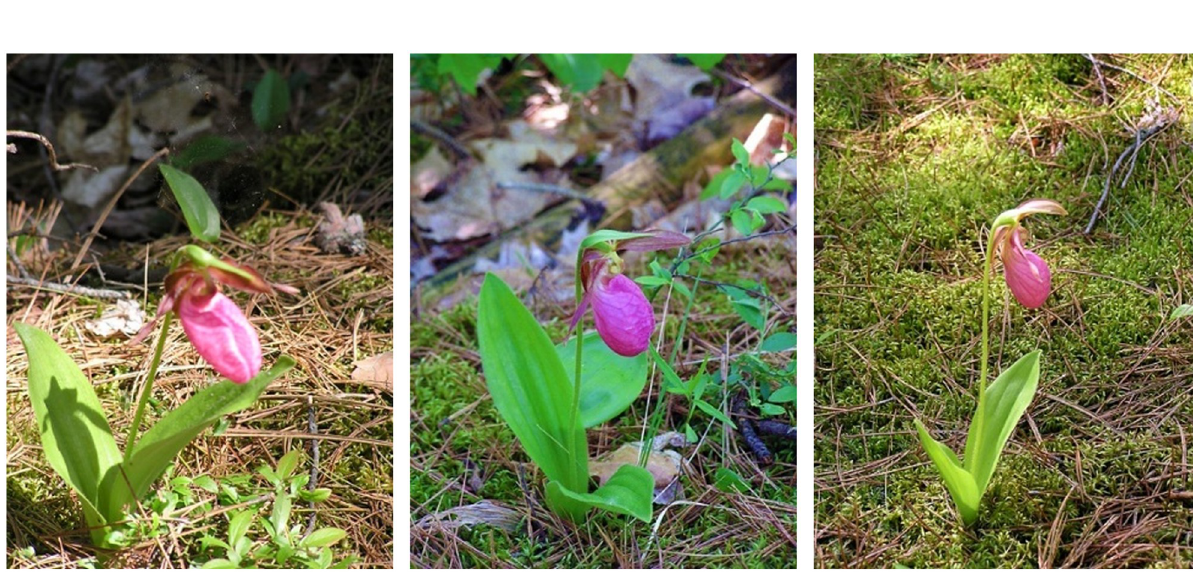
Fig 14. According to the literature, the orchid should be white. Yet, the picture clearly shows a pink-purple flower, where the classifier predicted purple as color (which includes pink in our color scheme), which was counted as being incorrect.